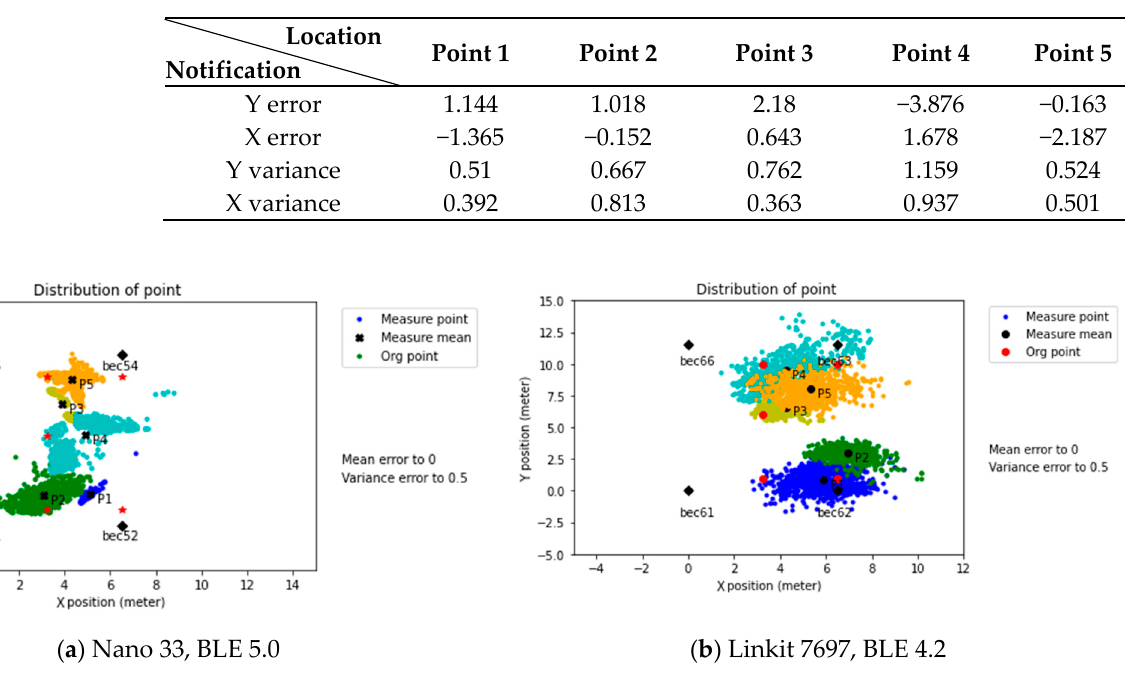
Figure 14. Comparison of the points section in the positioning accuracy.